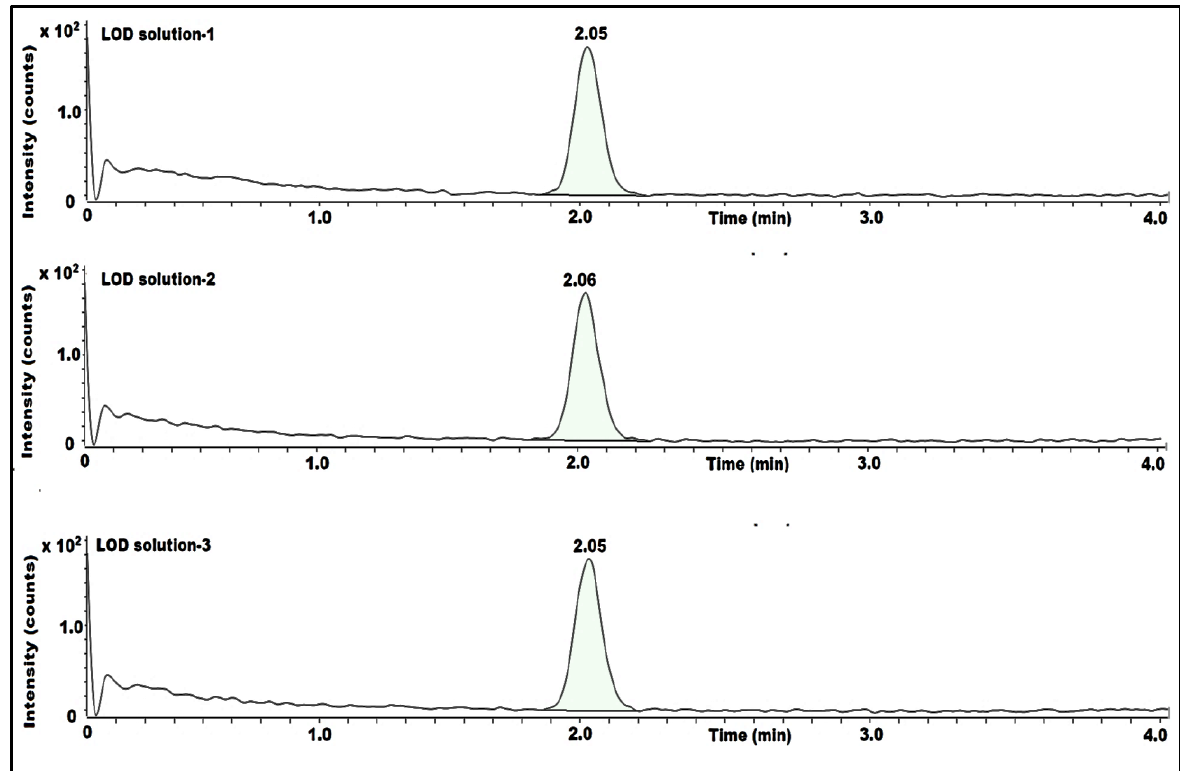
Figure 5. LOD solution chromatogram.